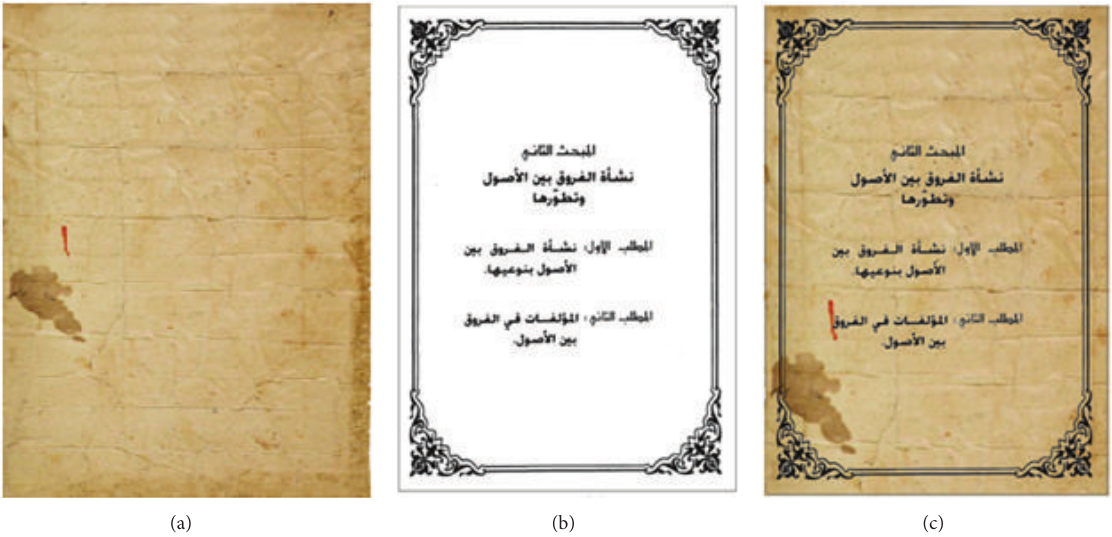
Figure 4: Image of document obtained by fusing binary image and background. (a) Background from old document, (b) ground truth binary image, and (c) the resulting synthetic